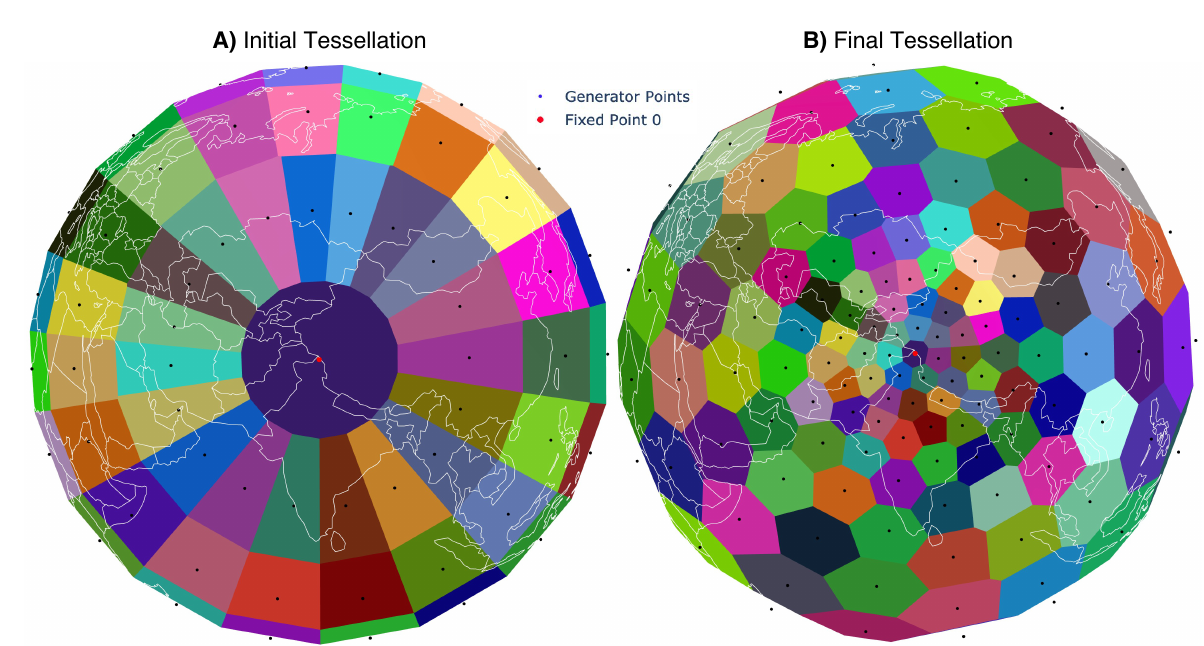
Figure 1. The initial ( A ) and final ( B ) tessellations generated after 50 iterations of the Voronoi scheme with weighted centroids towards the fixed point represented by the red dot. The blue dots are the generators. The Voronoi surfaces are shown in random colors. The boundaries of countries are shown in white, as a